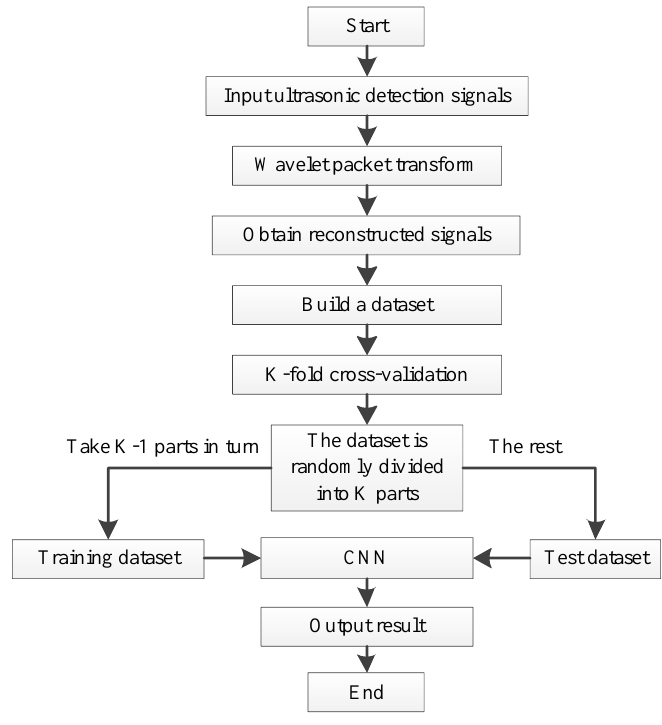
Figure 4. Flow chart of the proposed classification